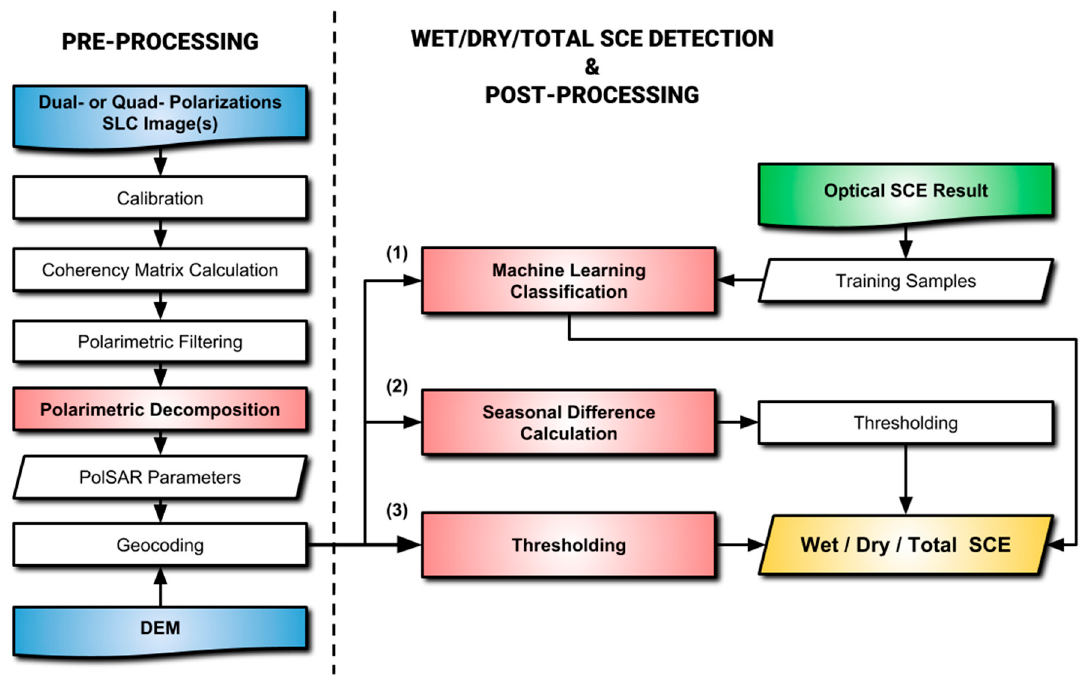
Figure 8. The overall workflow of polarimetric SAR (PolSAR)-based algorithms to detect wet and dry snow cover, including (1) machine learning classification trained by external SCE result; (2) the calculation of seasonal parameters’ difference before thresholding, and (3) the direct thresholding.